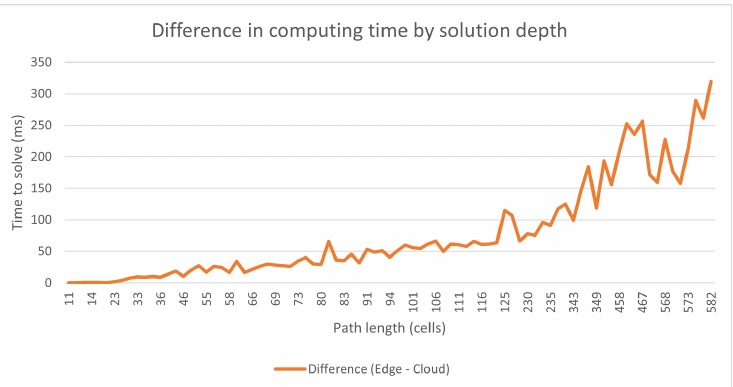
Figure 2. Measured difference in solution times on differently sized maps and different path lengths. It is noticeable that solution time differs insignificantly with smaller maps or shorter paths; however, the difference grows with increasing map and path